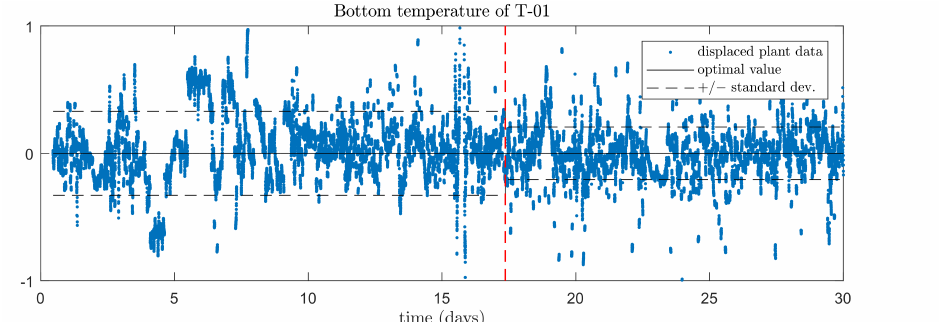
Figure 11. Optimization results: bottom temperature of T-01 deviated from the optimal value before and after the RTO loop closing.